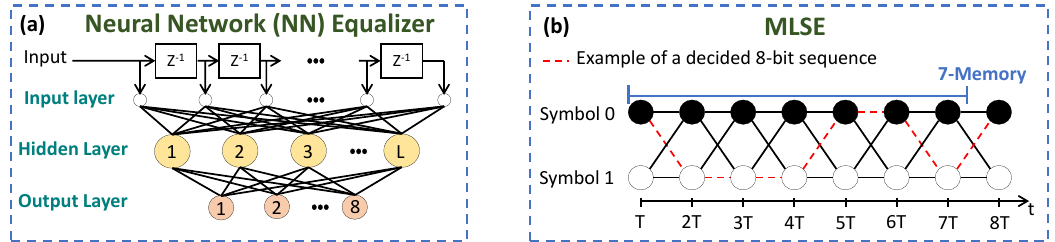
Figure 5. Digital processing algorithms used to process the signal. ( a ) NN equalizer. ( b )